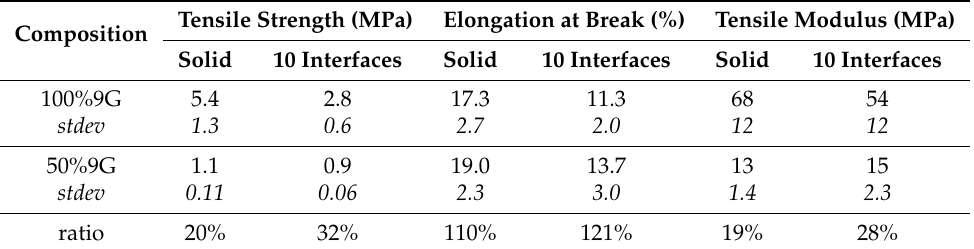
Table 1. Tensile properties of 9G and 9G/epoxy as a solid bar or 10-layer bar. Tensile Strength (MPa) Elongation at Break (%) Tensile Modulus (MPa) Composition Solid 10 Interfaces Solid